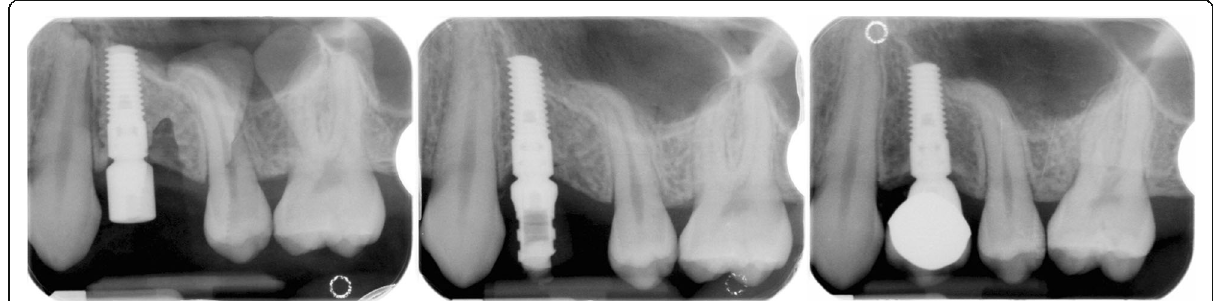
Fig. 2 Illustrative case of radiological follow-up period in the upper jaw. T0 in the left image, T1 in the central, and T2 in the right